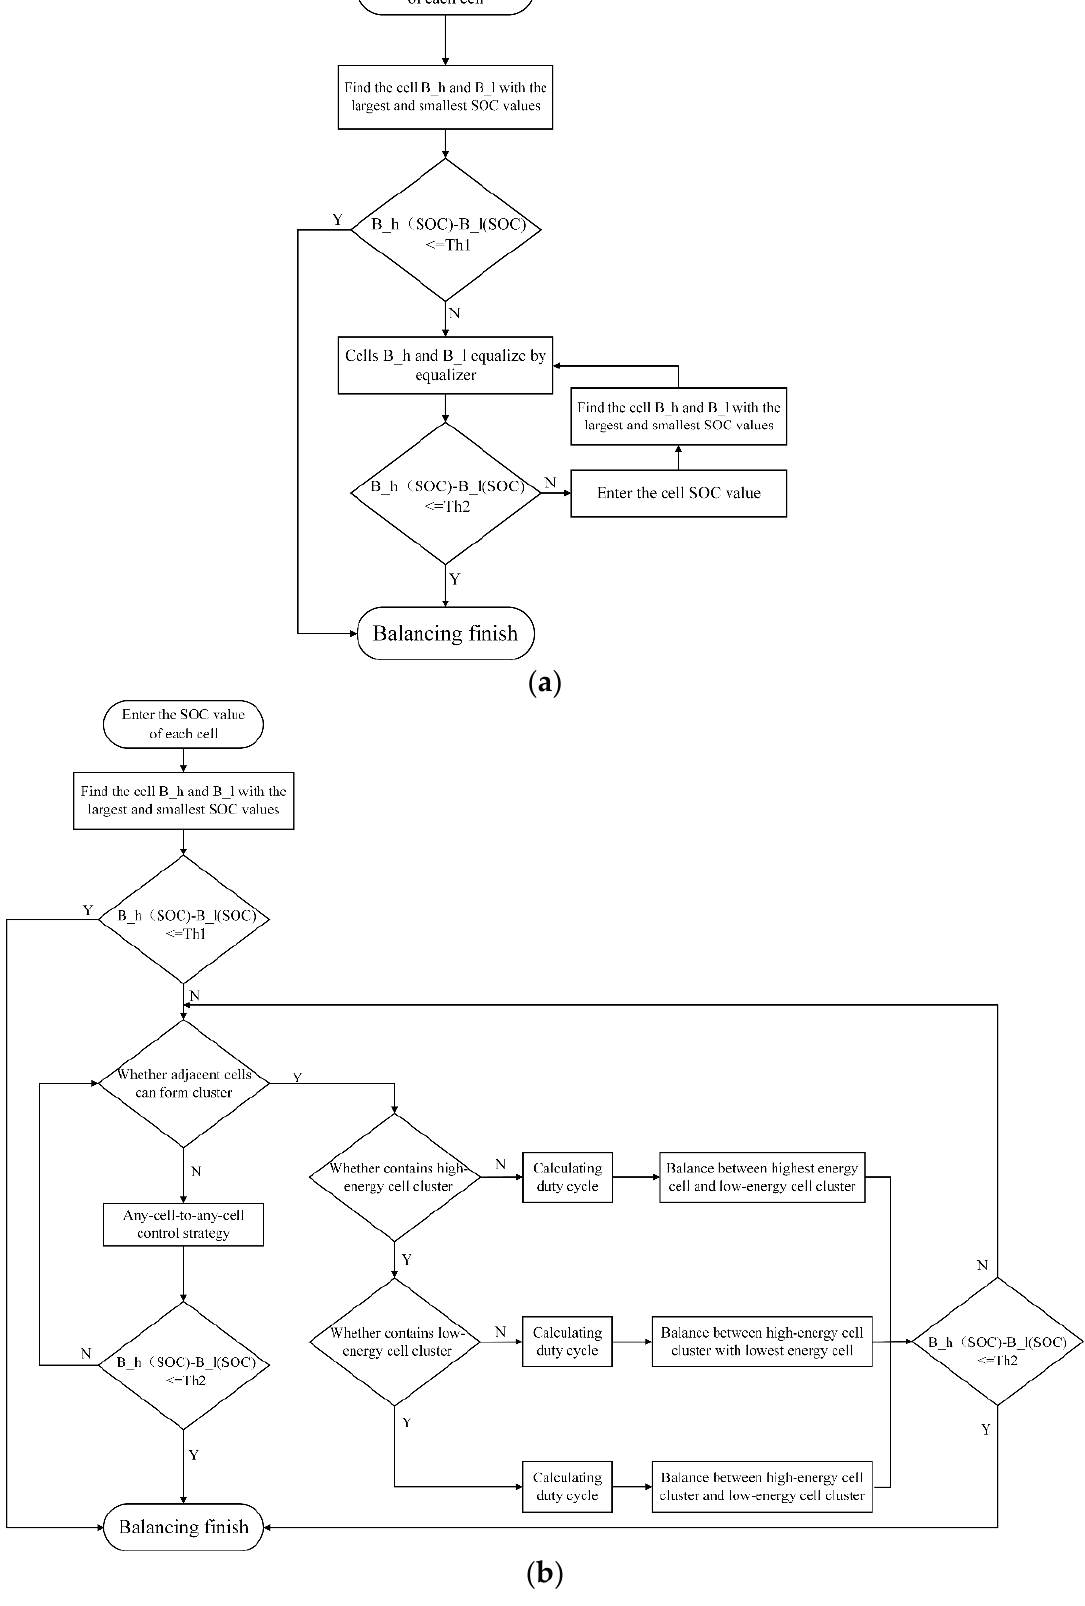
Figure 16. ( a ). Any-cell-to-any-cell control strategy. ( b ). Multi-cell-to-multi-cell control strategy.